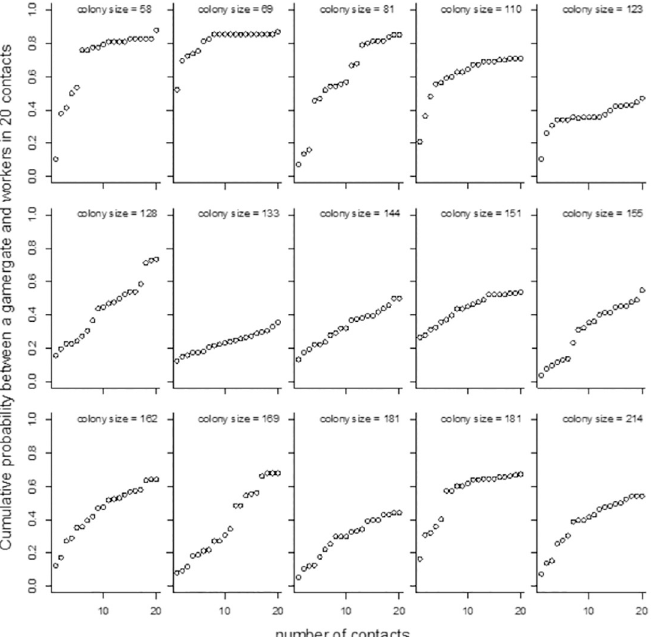
Fig 3. Cumulative proportion of workers contacted by the queen during patrols at various colony sizes during laboratory experiments.